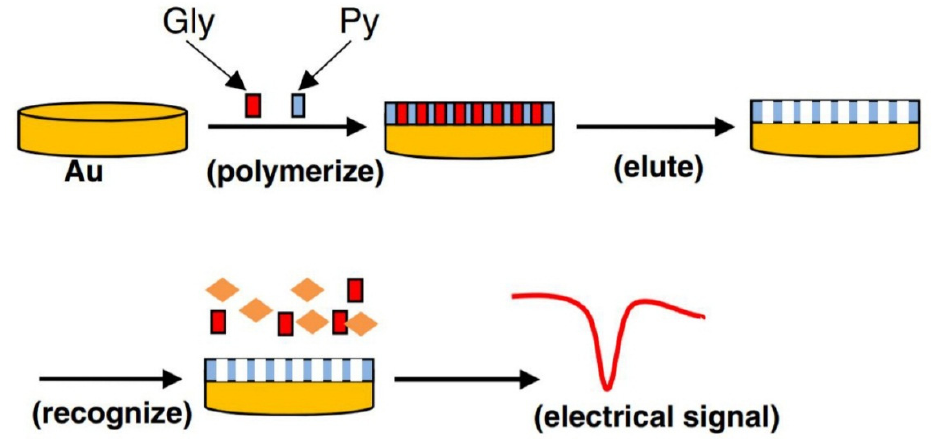
Figure 2. Molecularly imprinting for the electrochemical detection of glyphosate [38].